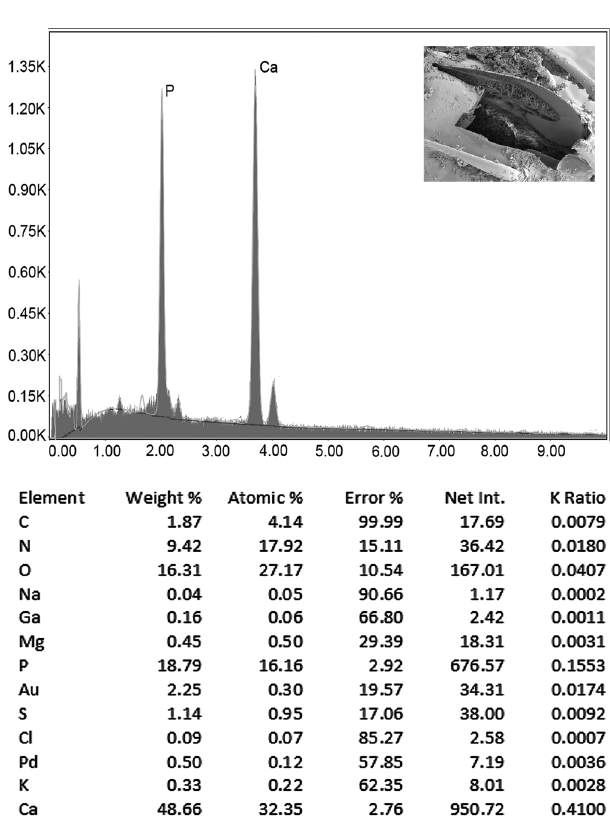
Figure 8. Energy Dispersive X-Ray spectrum of a Gallium cut hook tip of a Heterosentis holospinus specimen showing high levels of sulfur similar to those of the hook edge at mid-cut (Table 2). The X-ray data are the elemental analysis of the hook tip (see bolded fi gures in Table 2). Insert: SEM of a whole proboscis and cross sections near the hook tip of Gallium cut hooks showing the thick, high-sulfur hook edge.